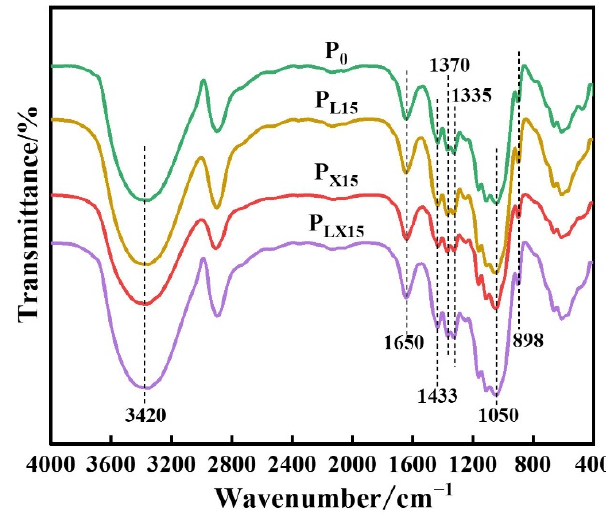
Figure 4. FTIR spectra of pulp before and after bio-enzyme pretreatment.